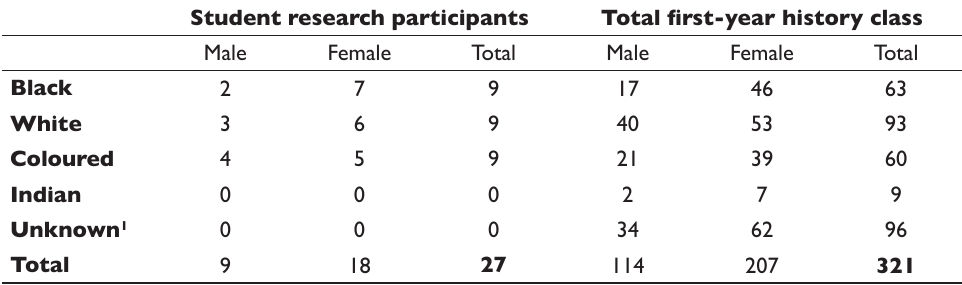
Table 1: TheprofileofresearchparticipantsandTotalfirst-yearhistoryclass(excludingnon-South